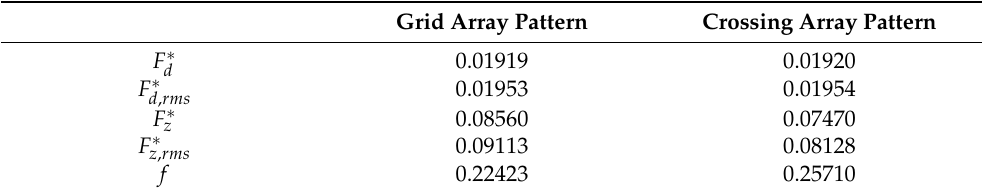
, and the friction coefficient f d